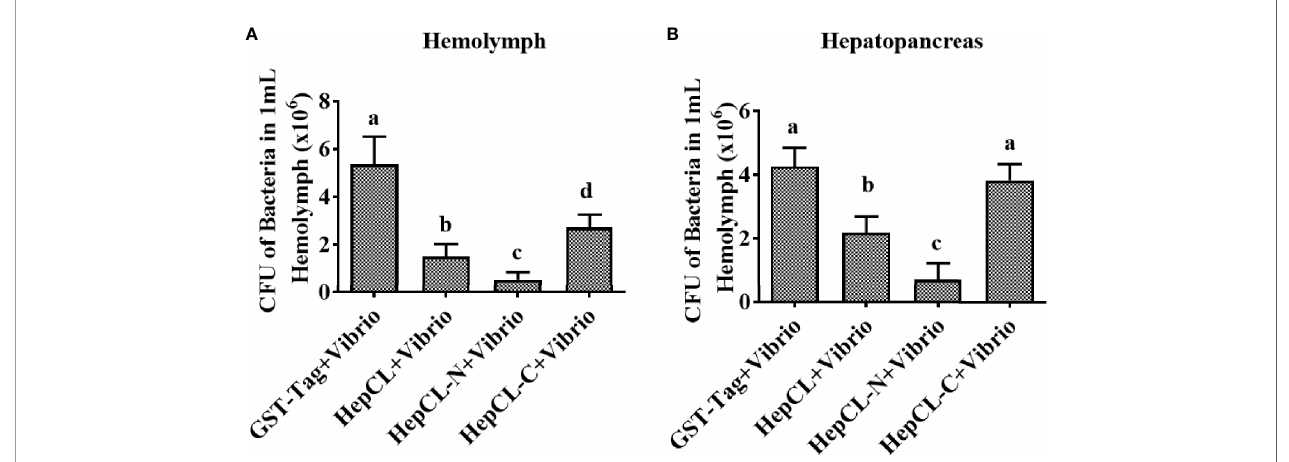
FIGURE 4 | Bacterial clearance assay. Bacterial clearance assay was involved to study the function of different domain of HepCL in antibacterial immunity. Cray fi sh were injected with HepCL, HepCL-N, HepCL-C 1 h later challenged with Vibrio , after 30 mpi, hemocytes (A) and hepatopancreas (B) were collected and the number of bacteria was counted. The group of GST-tag was used as control. Differences between groups were analyzed using one-way analysis of variance (ANOVA). Different letters indicate signi fi cant differences (p < 0.05).